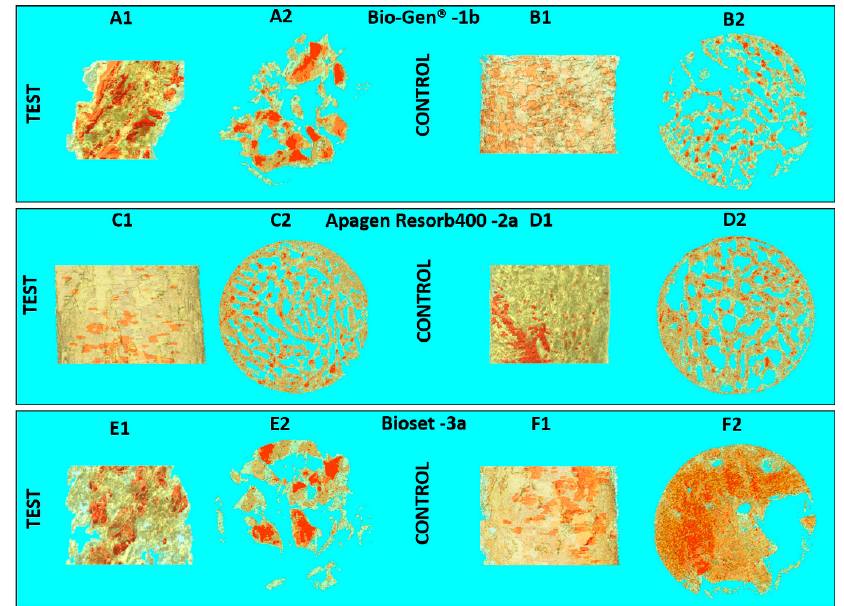
Figure 4. Clinical phase—Part 1, micro-CT reconstructed images for specimens test (left side) and control site (right side): ( A1 ) 1b test, section of the entire specimen; ( A2 ) 1b test, selected slice; ( B1 ) 1b control, section of the entire specimen; ( B2 ) 1b control, selected slice; ( C1 ) 2a test, section of the entire specimen; ( C2 ) 2a test, selected slice; ( D1 ) 2a control, section of the entire specimen; ( D2 ) 2a control, selected slice; ( E1 ) 3a test, section of the entire specimen; ( E2 ) 3a test, selected slice; ( F1 ) 3a control, section of the entire specimen and ( F2 ) 3a control, selected slice.